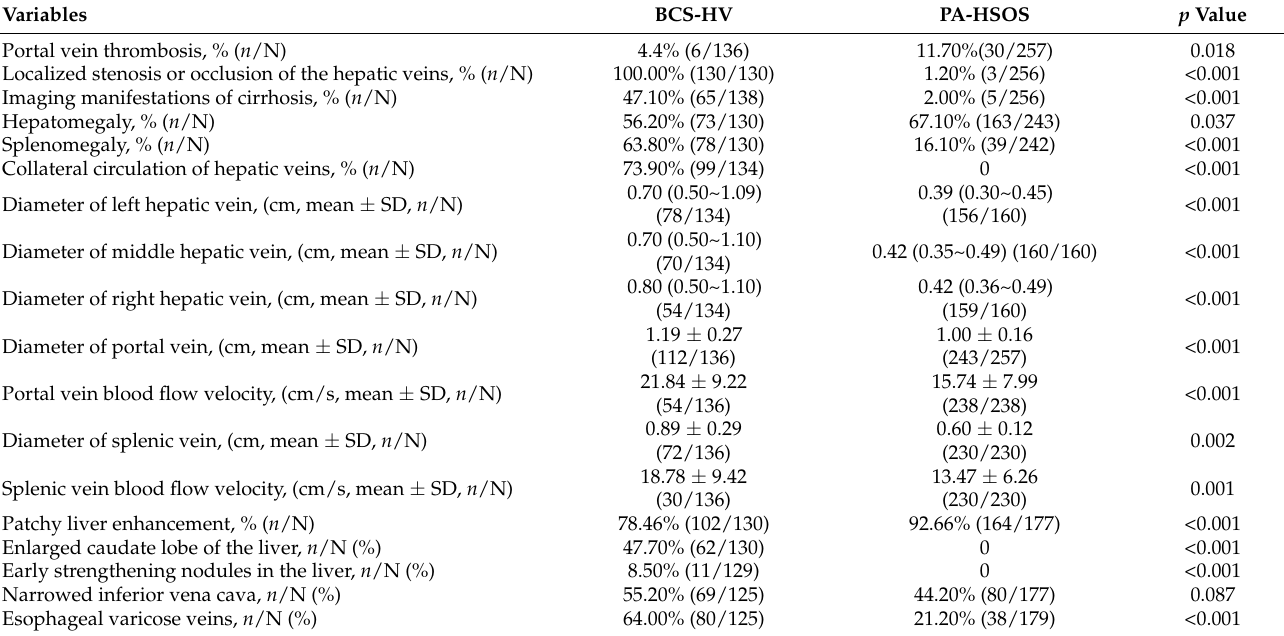
Table 3. Imaging features of patients with BCS-HV and